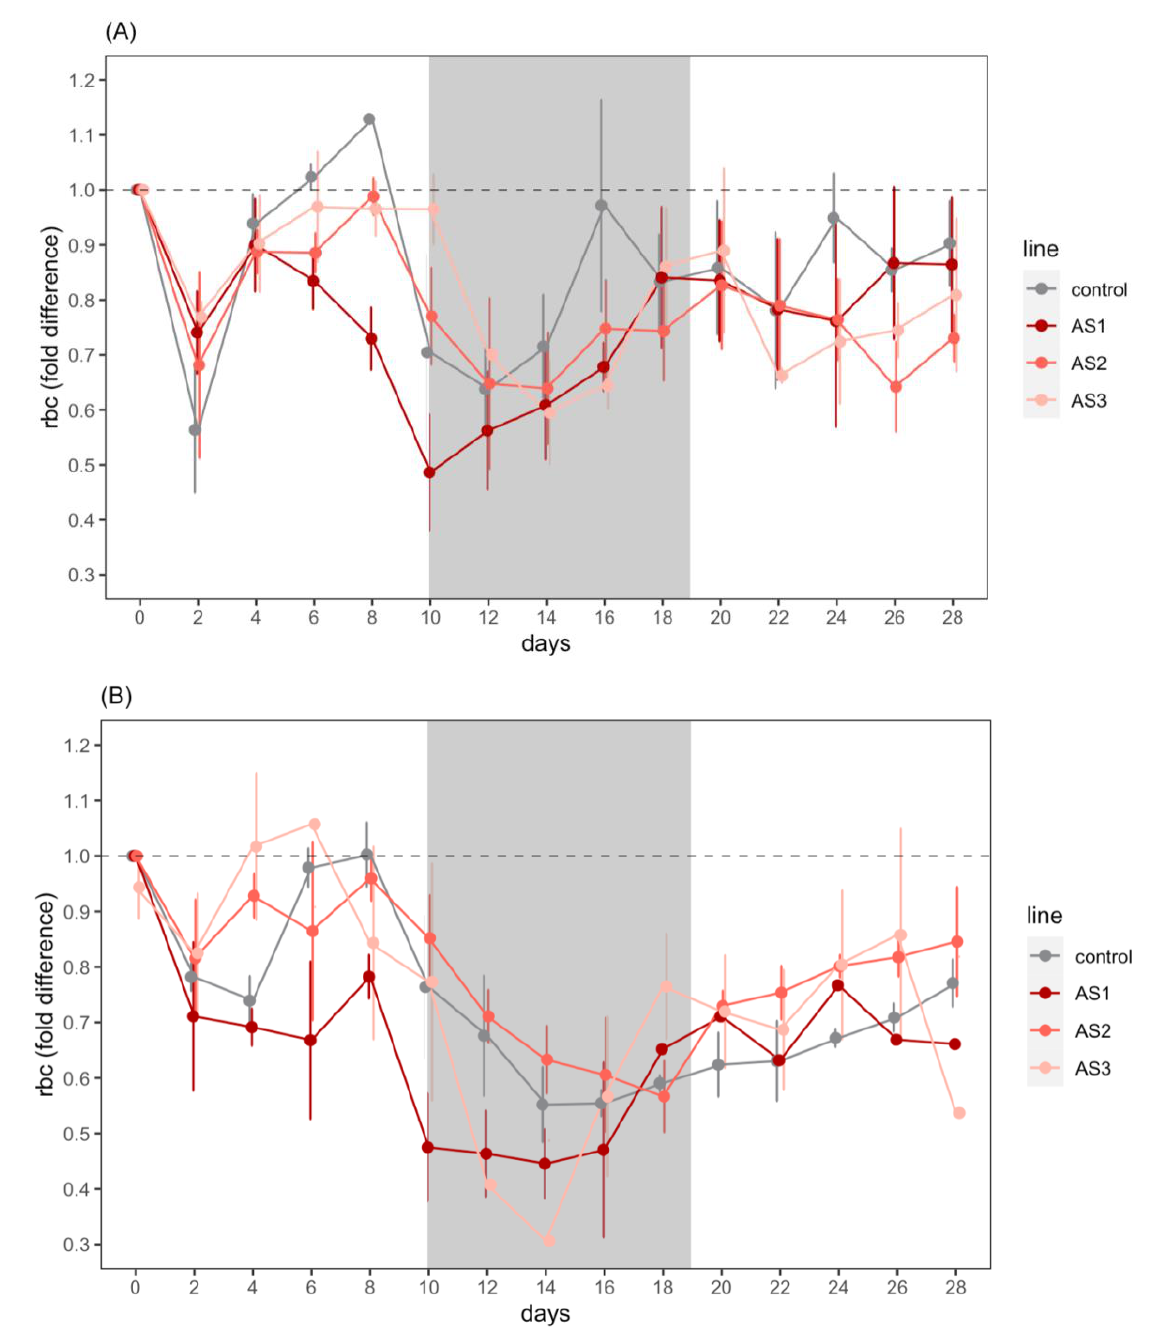
SF3: Bird red blood cell count (rbc) changes (mean ± s.e) in artesunate-treated ( A ) and untreated ( B ) birds. Shaded area corresponds to the 4-day treatment period. Untreated birds were sham injected with the artesunate solvent. Dashed line indicates the baseline rbc at the start of the experiment (day 0). Bars above/below the dashed line indicate an increase/decrease in rbc with respect to day